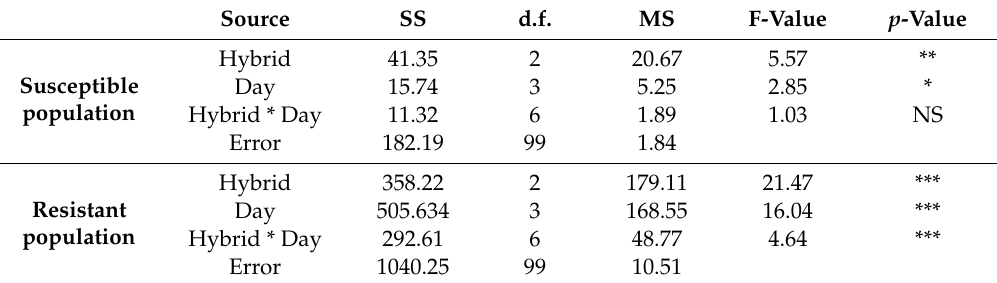
Table 1. Repeated measures analysis of variance of the plant abandonment test conducted with neonate B. fusca larvae of a Bt-resistant (conducted in March 2018) and susceptible (conducted in November 2018) population. The number of larvae that abandoned maize plants of three treatments was recorded daily for 4 days after inoculation. The treatments were non-Bt (DKC 8010), MON810 (DKC 8012 B), and MON89034 (DKC 8012 B